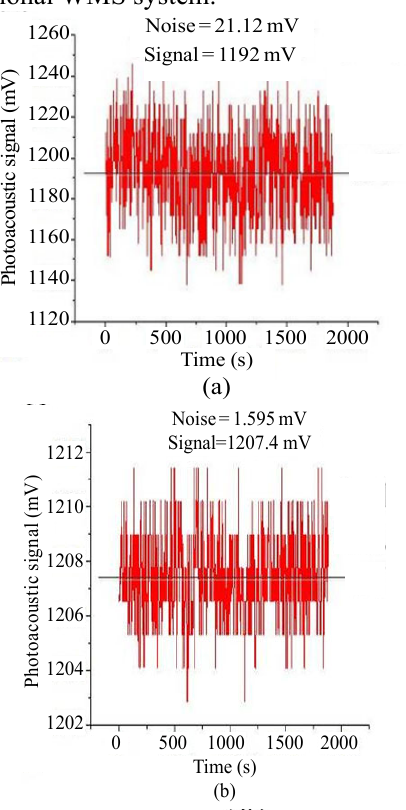
Fig. 10 Photoacoustic signal in: (a) conventional WMS system and (b) wavelength calibration